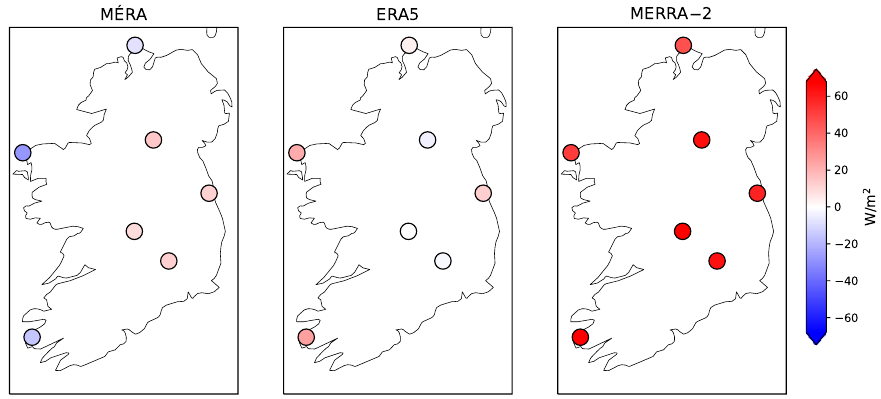
Figure 7. Mean error for summer (JJA) SW at each station for each reanalysis.